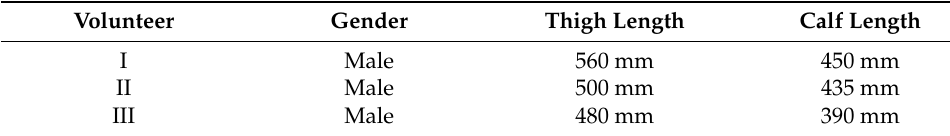
Figure 12. Experimental demonstration process. Table 3. The range of motion of three volunteers’ joints.